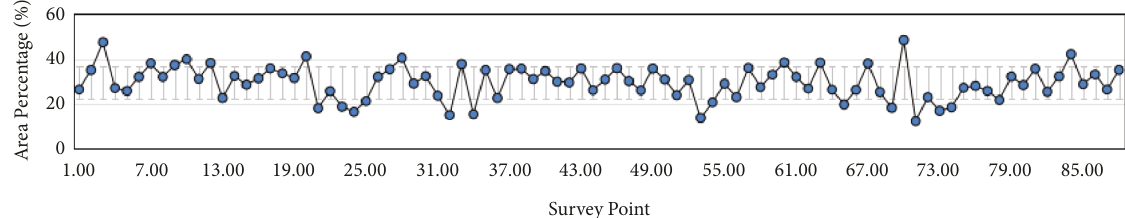
Figure 7: Proportions (in percentage) of the building areas at the survey sites to the corresponding polygon